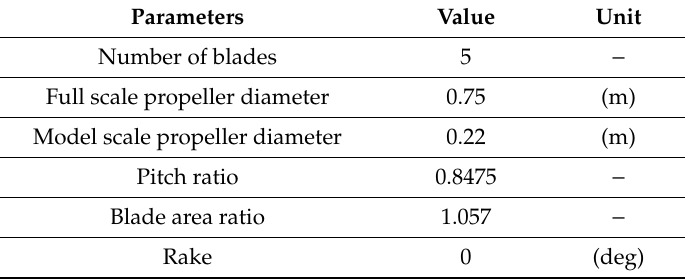
Figure 6. Manufacturing accuracy Image of the Princess Royal Propeller. Table 1. Propeller main characteristics and